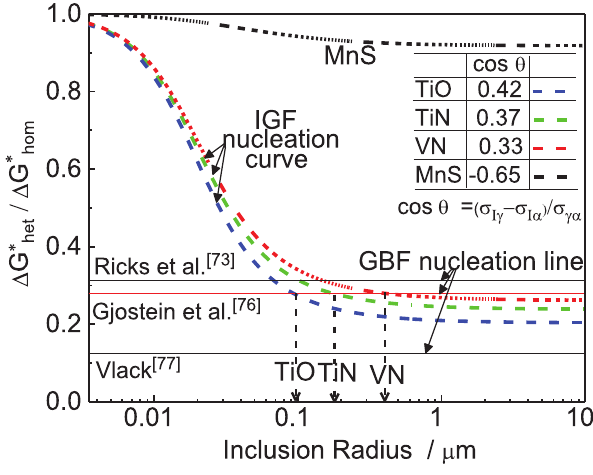
Figure 13: Calculated results of the energy barrier of heterogeneous nucleation,correspondingtothevalueofhomogeneousnucleation[10].